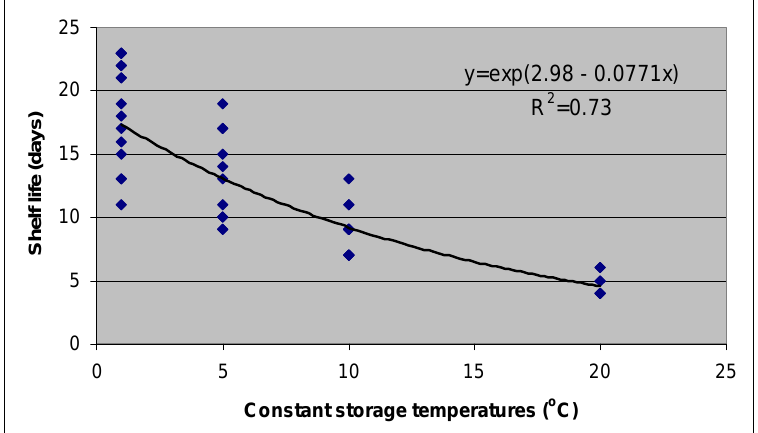
Figure 1. Total shelf life (y-axis) of living lettuce was affected by constant storage temperatures of 1°, 5°, 10° or 20°C (x-axis). The exponential equation was based on Proc NLIN of SAS software package (SAS 9.1.3, 2002-2003 release; SAS Institute Inc., Cary,